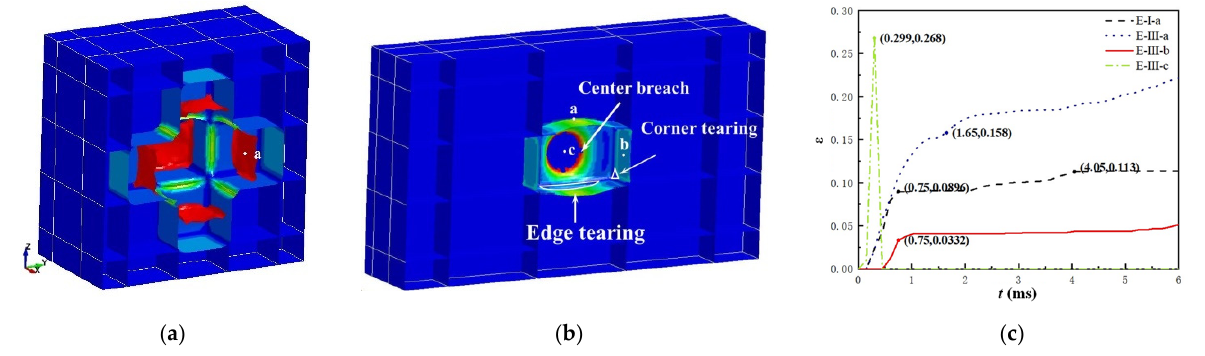
Figure 7. Damage results of multi-box structures with different structural dimensions. ( a ) E-I model t = 1.80 ms; ( b ) E-III model t = 0.90 ms; ( c ) Variation of effective plastic strain.